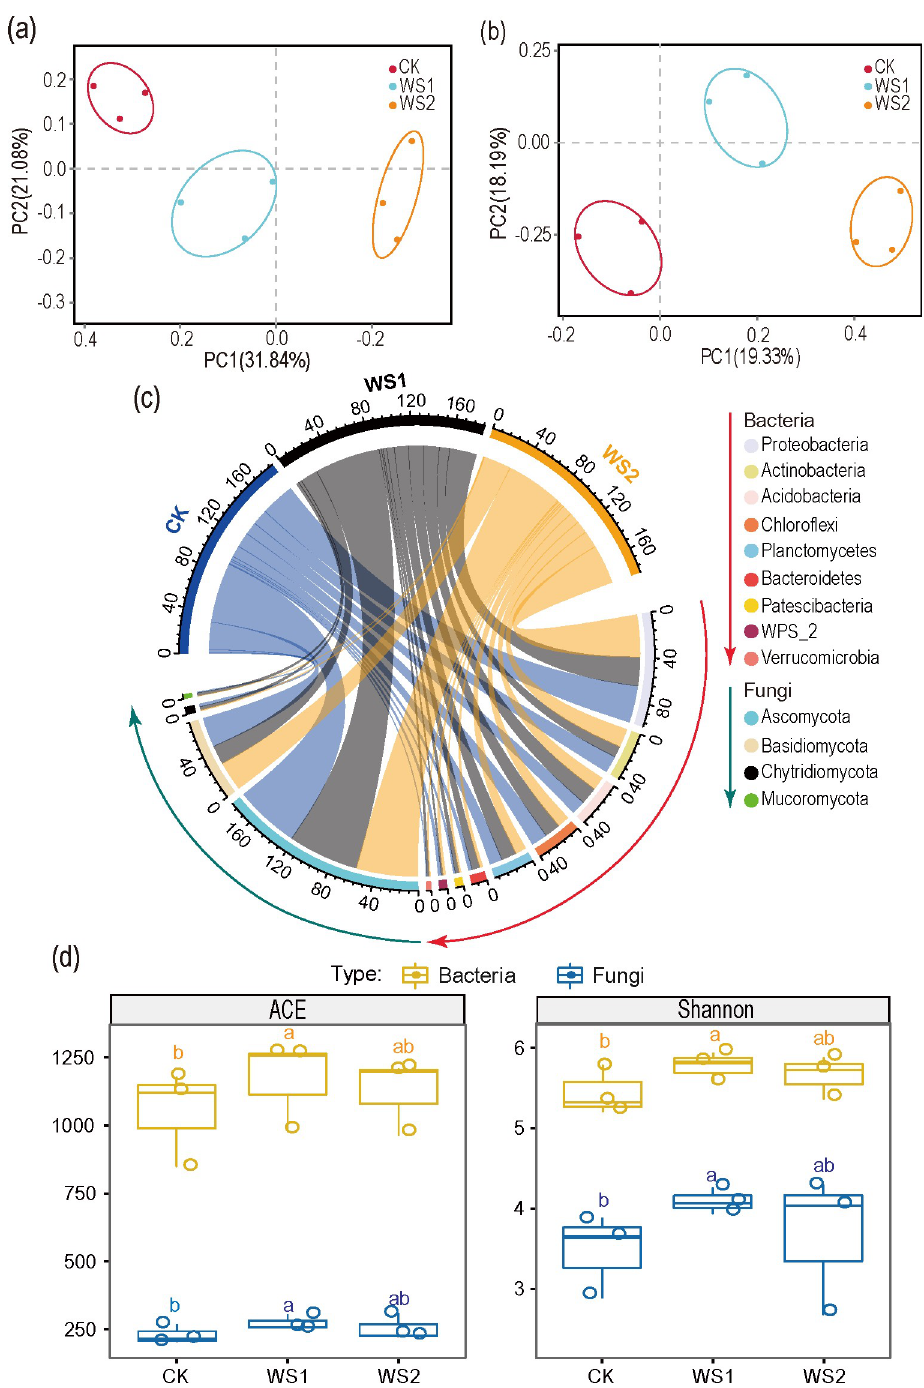
Fig 2. Microbial diversity analysis. Analysis of principal coordinates (PCoA) of bacterial (a) and fungal communities (b) of the Bray–Curtis in the various treatments were assessed. The Circos diagram depicts the top microbial composition at the phyla level in three sugarcane fields (c). Values means (n = 3). Box plots represent alpha diversity indices, including microbial community richness (ACE) and diversity (Shannon) under different treatments (d). Lowercase letters indicate the difference among treatments based on the LSD test (p < 0.05). CK: N, P, and K fertilizer; WS1: water soluble fertilizer 1,050 kg/hm 2 ; WS2: water soluble fertilizer 1,650 kg/hm 2